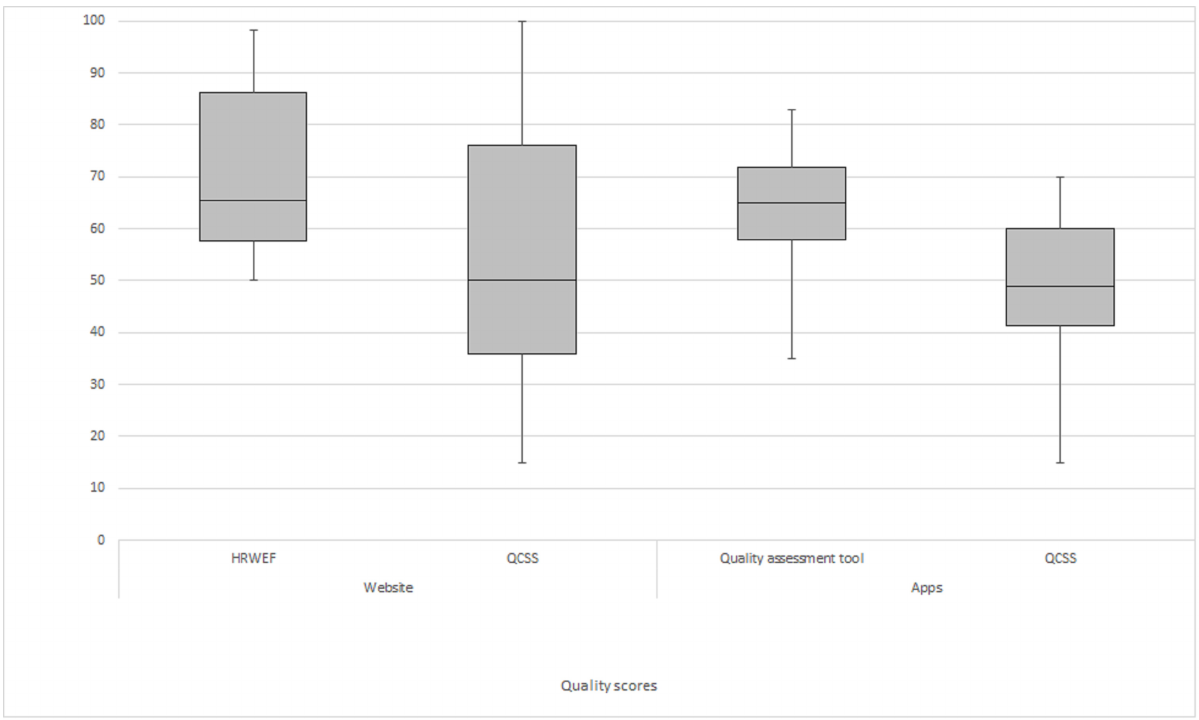
Figure 2. Quality scores of the websites and apps analyzed in this